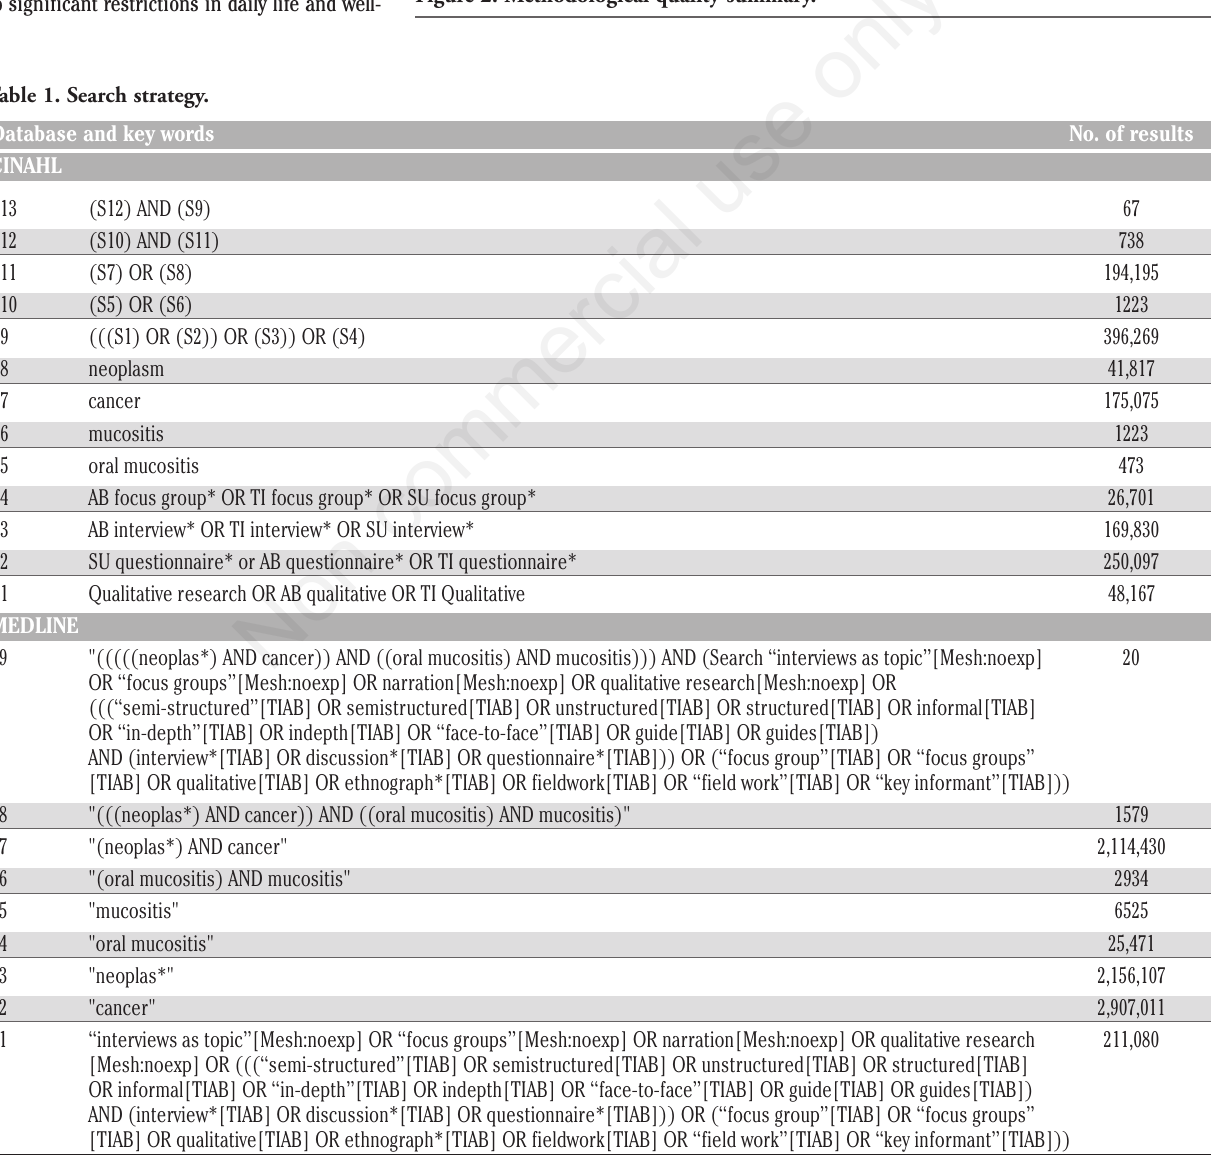
Figure 2. Methodological quality